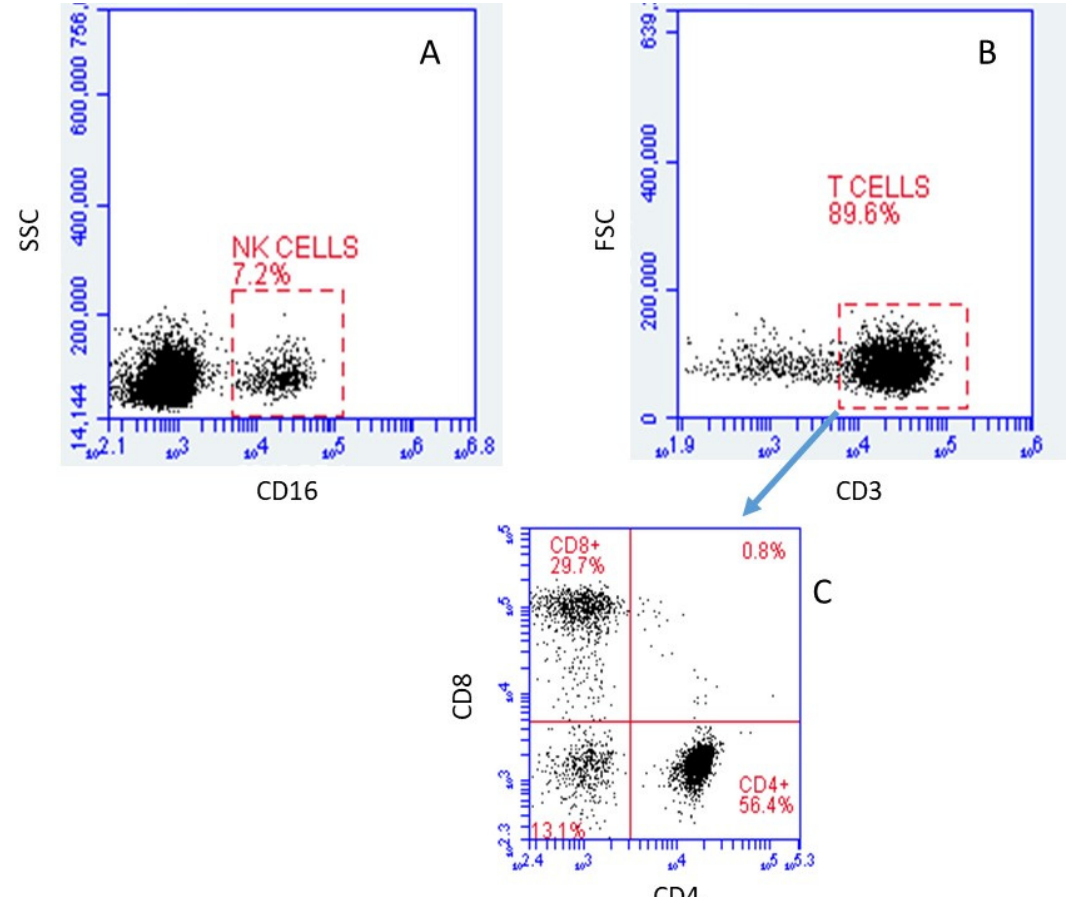
Figure 1. Immunophenotyping via flow cytometry analysis of cells obtained after T Cell enrichment by high affinity negative selection human T cell enrichment columns (SSC: Side scattering; FSC: Forward scattering). ( A ) Relative size vs. CD16 relative intensity, gated on CD45+. ( B ) Relative granularity vs. CD3 relative intensity, gated on lymphocytes. ( C ) CD8 vs. CD4 relative intensities, gated on T cells. Of the CD45+ population, 7.2% were positive for CD16, while 89.6% of the lymphocyte population was positive for CD3. Cells that were positive for CD4 or CD8 (but not both) accounted for 56.4% and 29.7% of CD3+ cells, respectively.